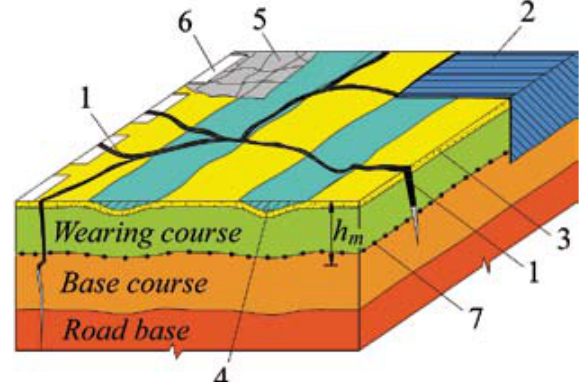
Fig. 1. Fragment showing the distribution of additional materials used for increasing the homogeneity of RAP, improving its surface texture and repairing damages: 1 – paste, emulsified asphalt or bitumen for filling cracks; 2 – asphalt mixture and bitumen priming for filling pot-holes; 3 – bitumen binder and mineral aggregates of surface coating; 4 – asphalt mix or slime for filling ruttings; 5 – layer of emulsified asphalt and filler for sealing the net of cracks; 6 – horizontal pavement marking materials; 7 – geogrid or geotextile with emulsified asphalt; h m – average depth of milling (normally from 40 to 100